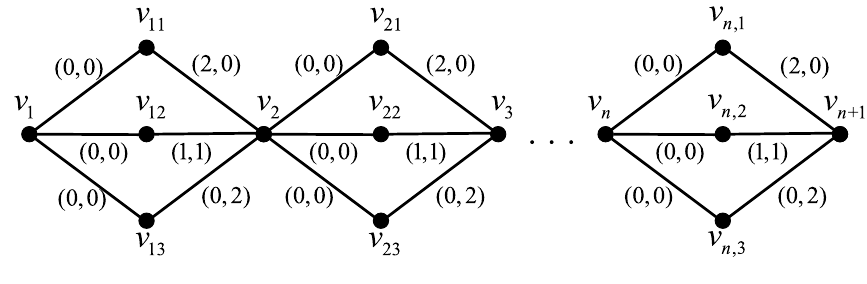
Fig. 3 An instance G ′ of the CMST